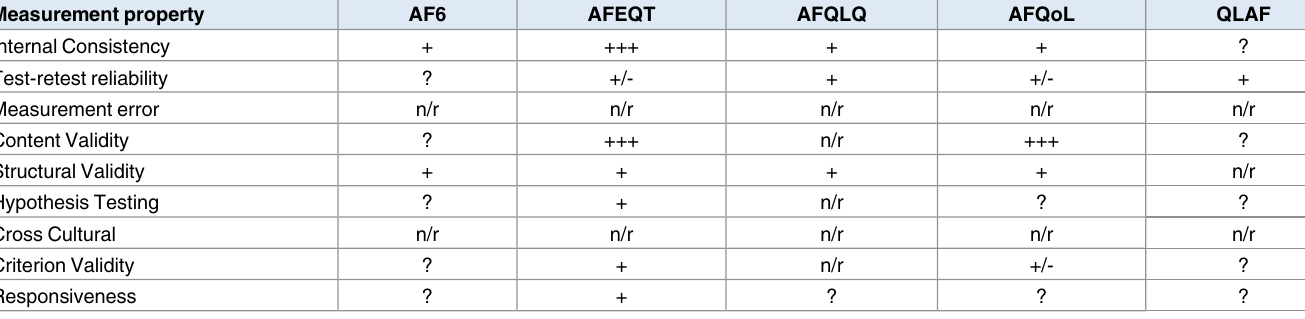
Table 3. Synthesis of